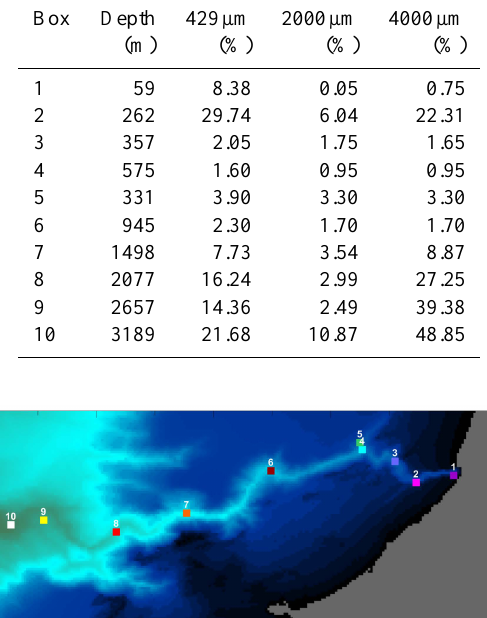
Table 2. Percentage of OMAs escaping from the monitor boxes pre- dicted by the model.